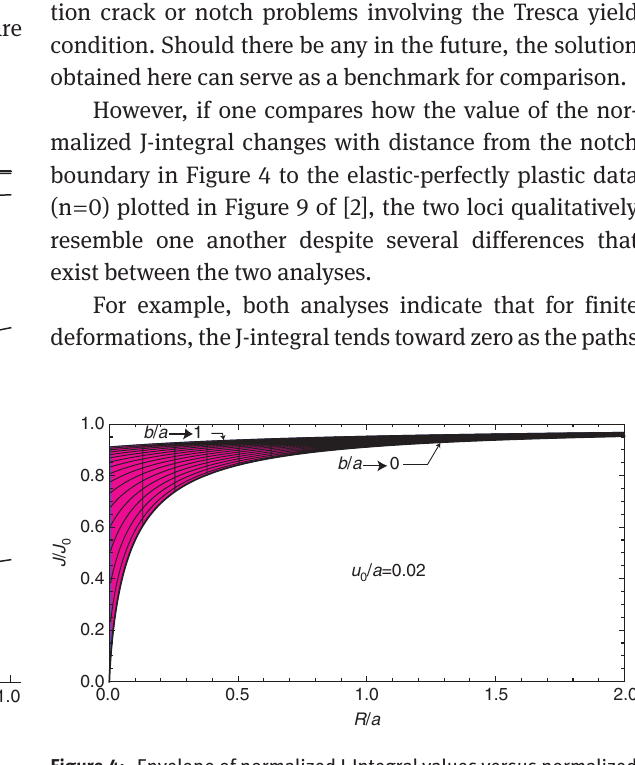
Figure 3: Normalized J-integral along the elliptical hole boundary versus axes aspect ratio and normalized displacement.